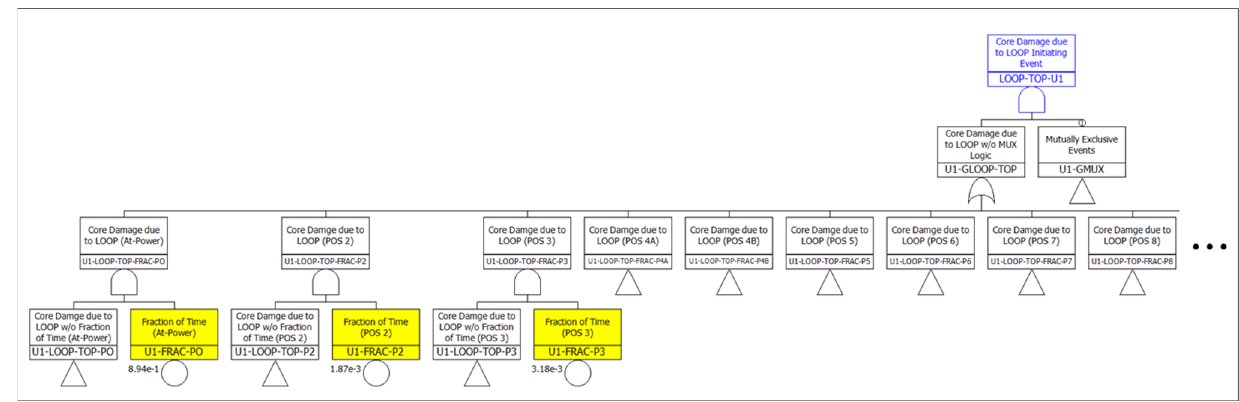
Figure 3. Example integrated single-unit model combining FP and LPSD PSA models.